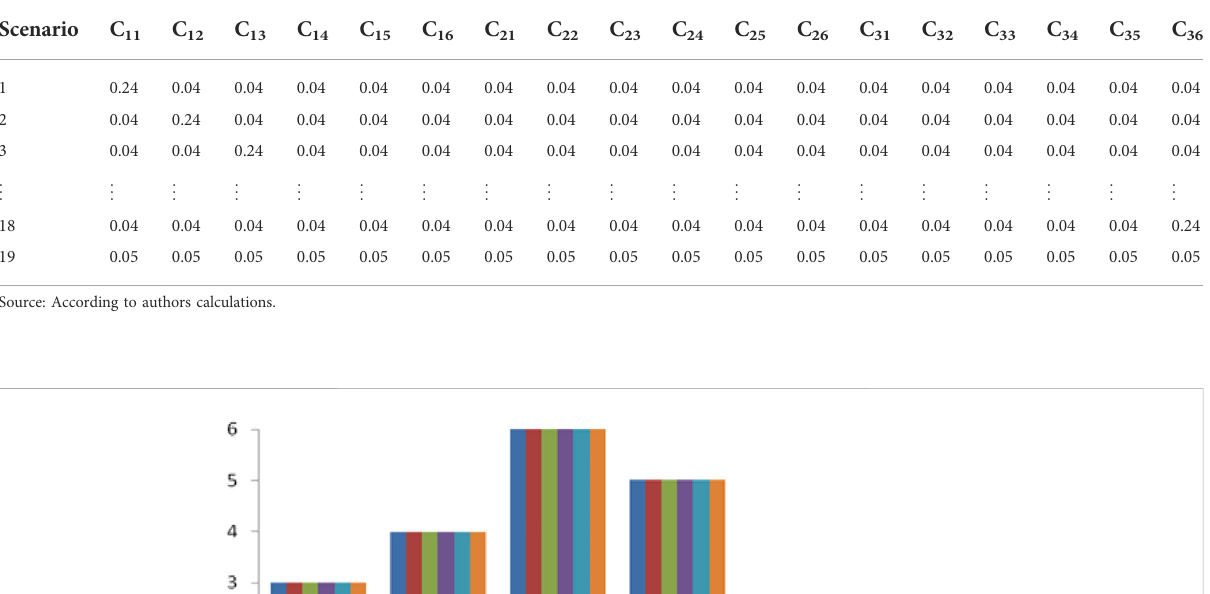
TABLE 9 Sensitivity analysis scenarios.